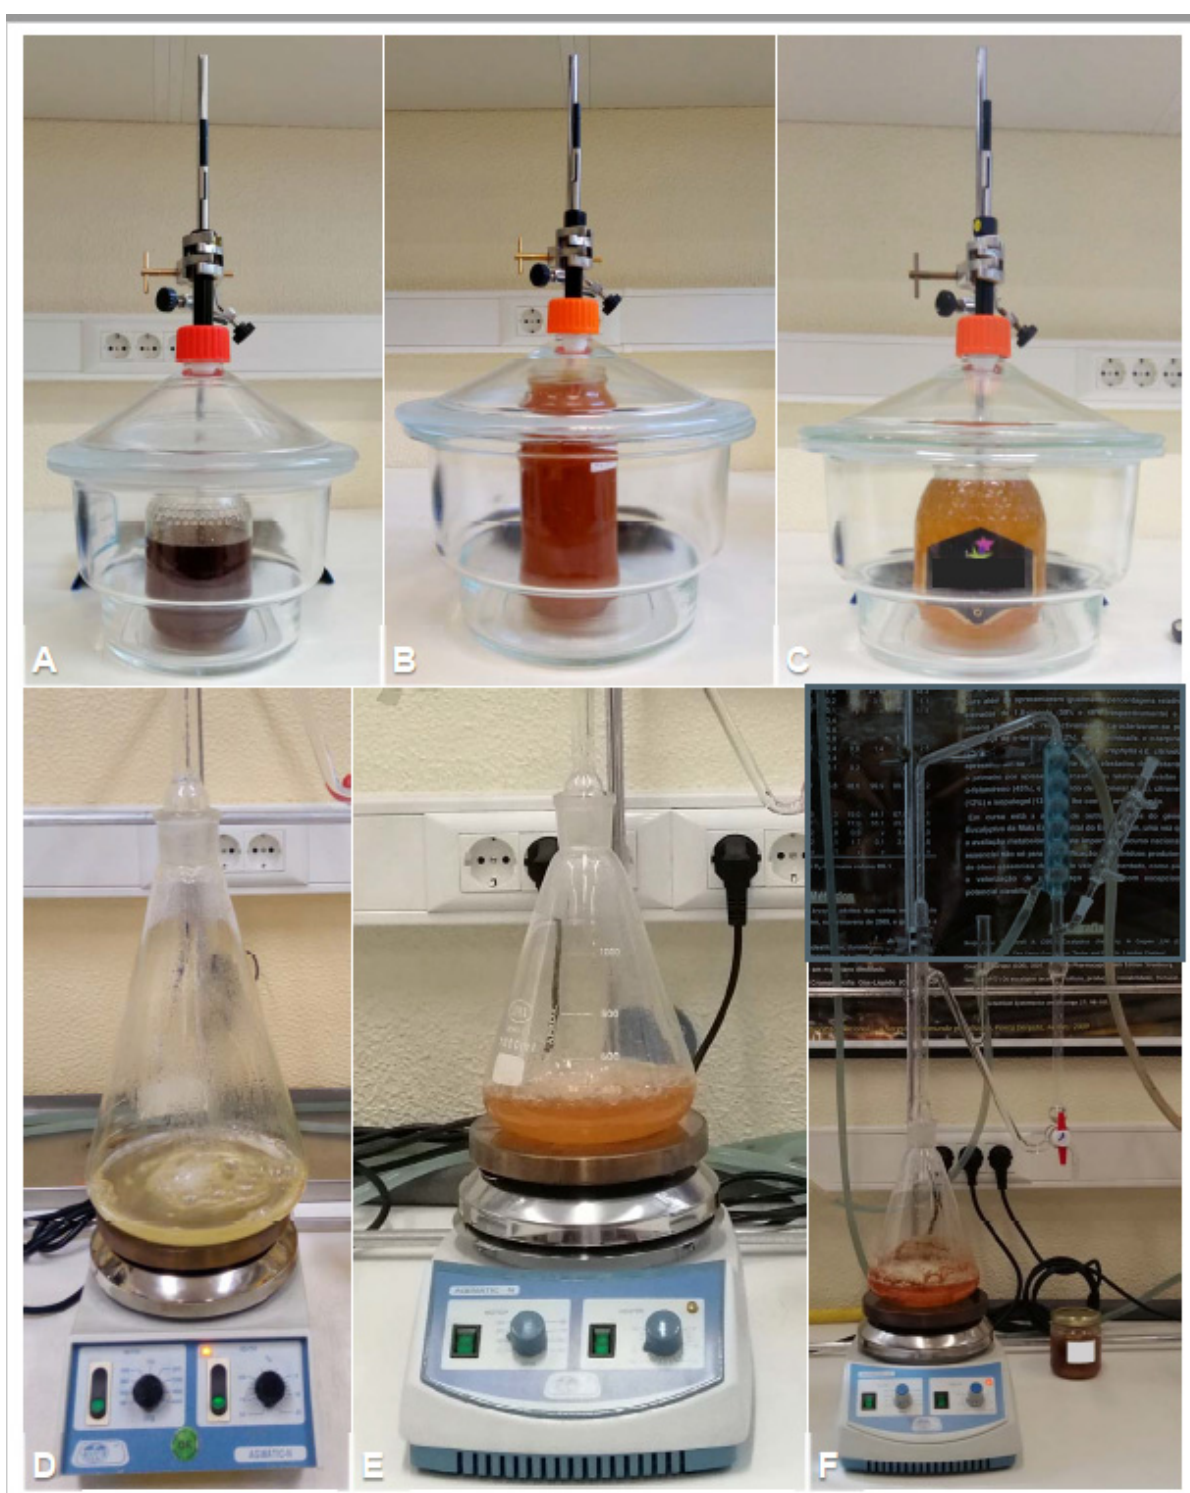
Figure 1. Extraction of volatiles from different honey samples. ( A – C ) SPME collection of volatiles from carob tree honey ( A ), eucalyptus honey ( B ) and lavender honey ( C ). ( D – F ) Hydrodistillation of orange honey ( D ), sunflower honey ( E ) and strawberry tree honey ( F ). Table 1. Monofloral-labelled honeys studied, their production regions and analysed flower types, with corresponding geographical origins and volatile components found in each honey’s botanical source.